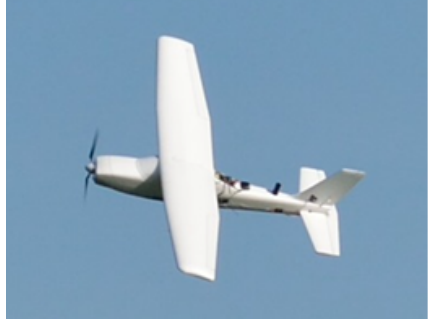
Figure 1. Model airplane in the